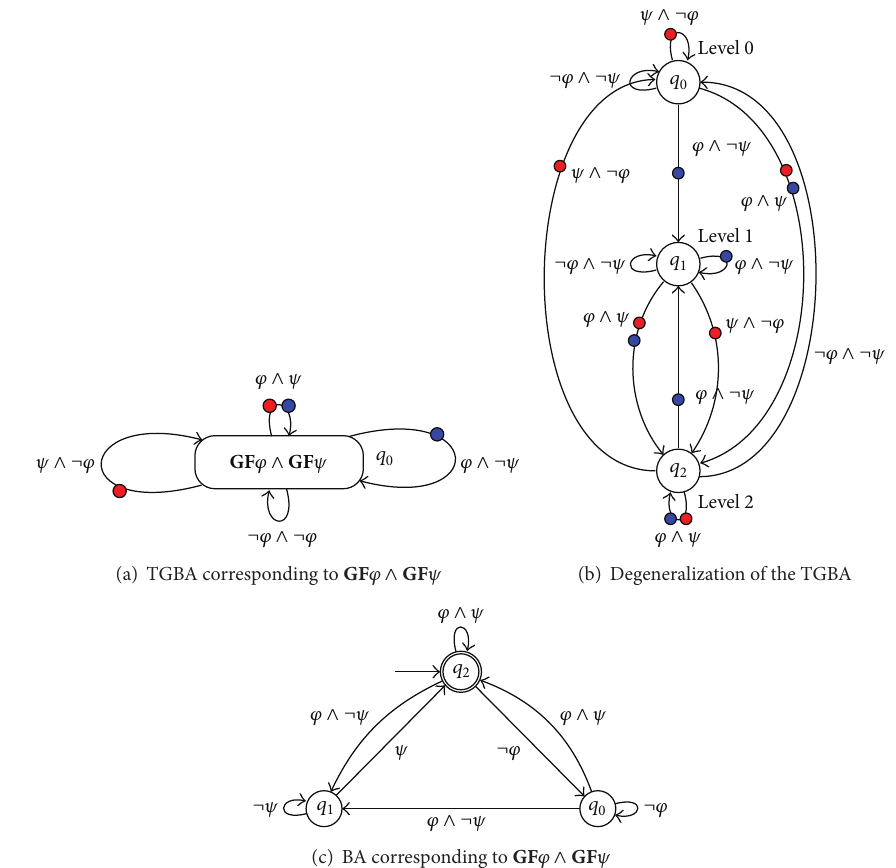
Figure 2: Degeneralization of a TGBA corresponding to GF 𝜑 ∧ GF 𝜓 using the standard degeneralization algorithm.